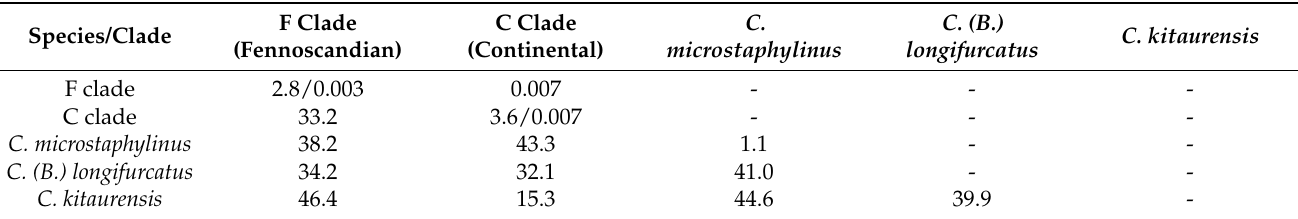
Table 4. Average model-corrected genetic distances (in %) between the two main clades (Fennoscandian and Continental) of Canthocamptus staphylinus and between them and other Canthocamptus species: below diagonal—COI, above diagonal—18S, in the diagonal—values within clades